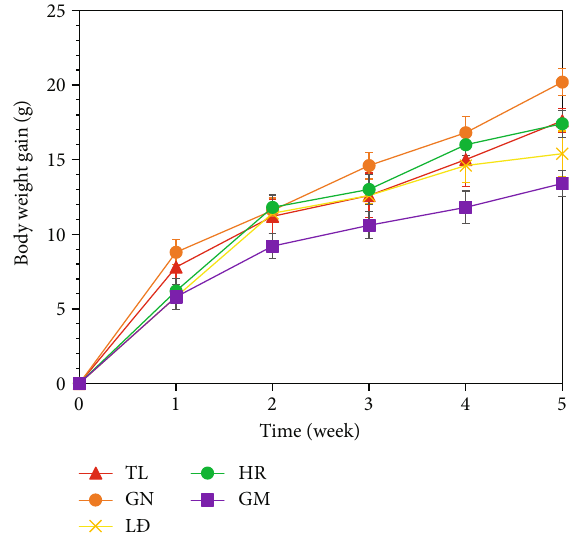
Figure 1: Body weight gain of mice.